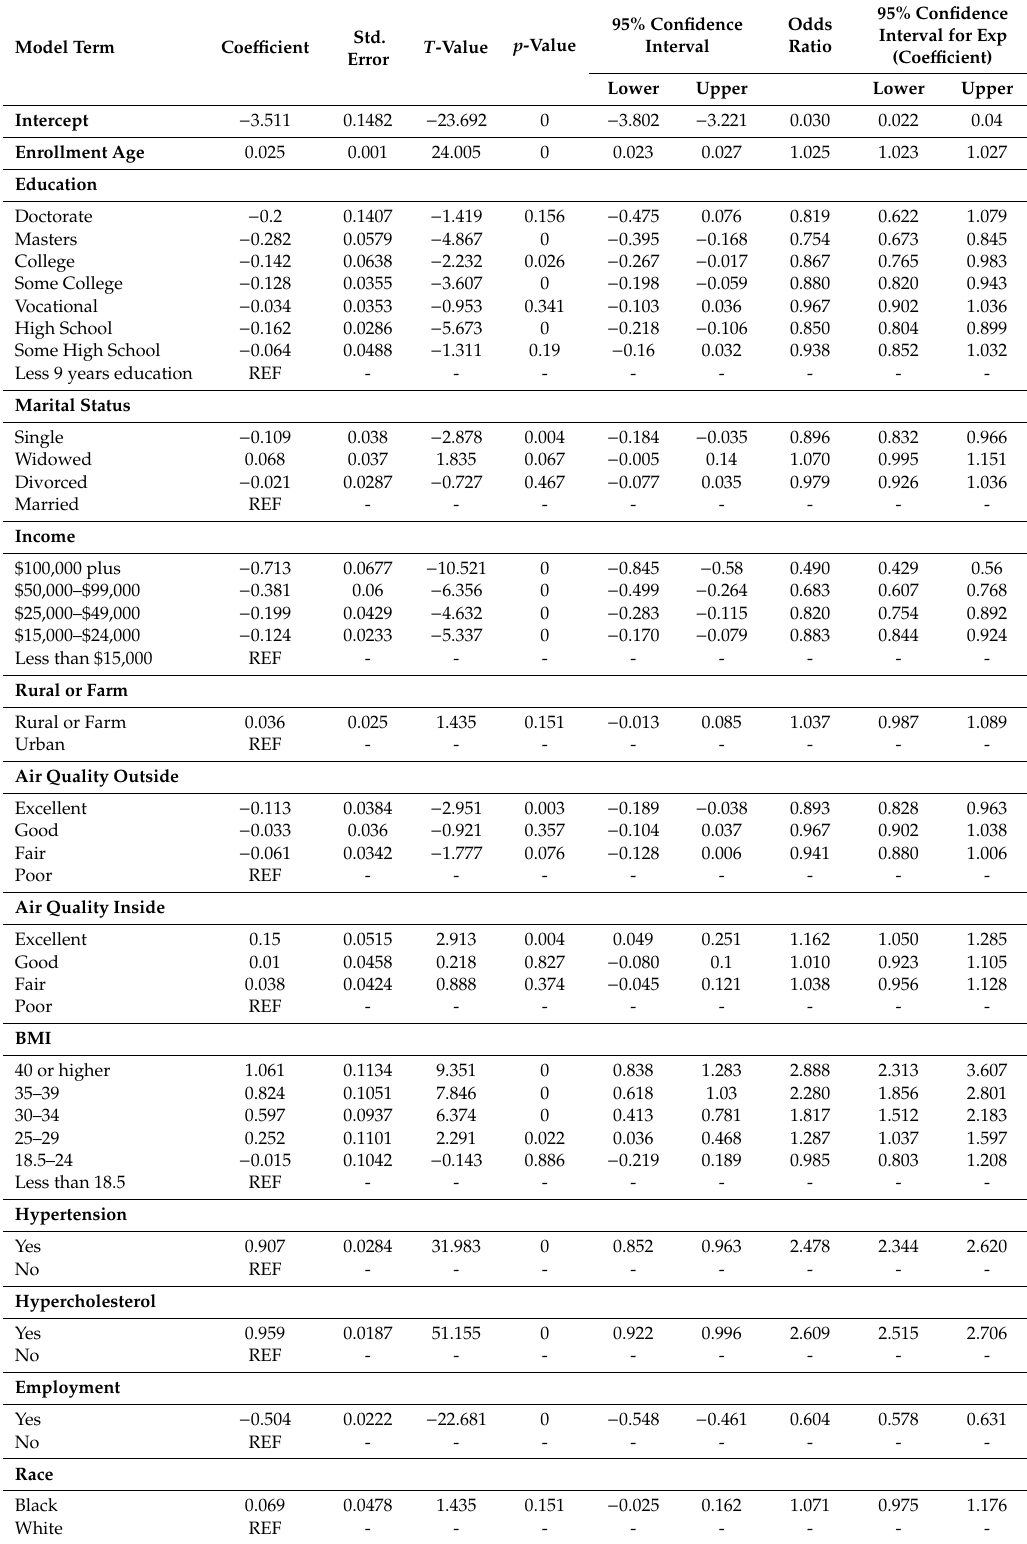
Table 3. Generalized linear mixed model fixed e ff ects estimates for presence of cardio-metabolic disease in FQHC cohort participants of the Southern Community Cohort Study ( n =